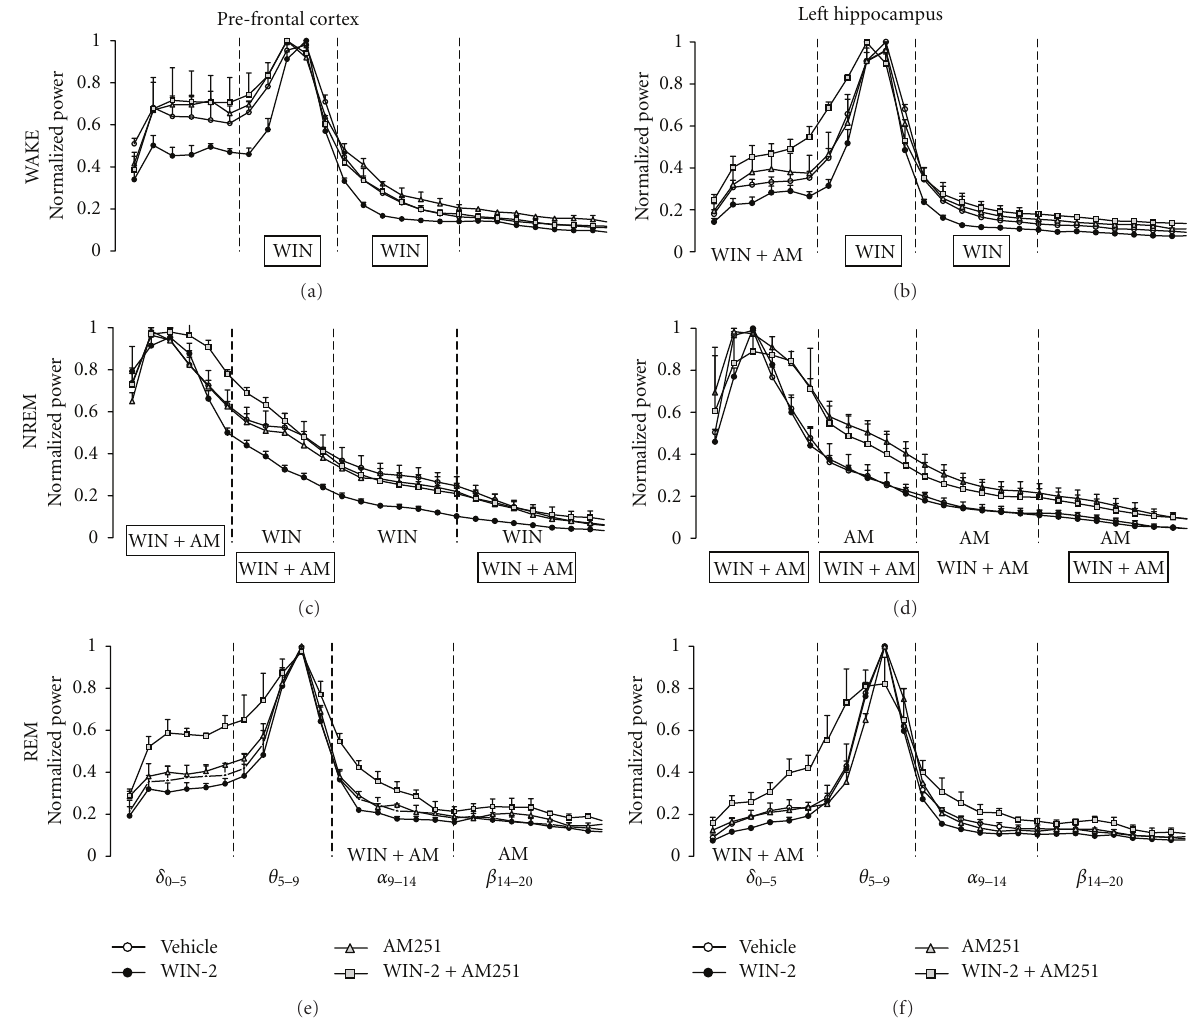
Figure 2: Normalized EEG power spectra recorded by electrodes positioned above the prefrontal cortex and parietal cortex/dorsal (left) hippocampus (frequency bands as indicated in e and f), following systemic treatment with vehicle (control), WIN-2 (1mg/kg), AM251 (2mg/kg), or WIN-2 (1mg/kg) + AM251 (2mg/kg) for vigilance stages of wakefulness (a and b), NREM (c and d) and REM (e and f) sleep, respectively. Significant e ff ects of treatment are depicted as WIN (WIN-2), AM (AM251), and WIN + AM (WIN-2 + AM251) for respective frequency bands in each subfigure (a–f). Rectangular markings indicate e ff ects common to both prefrontal and parietal recording sites. The normalized power for all data points (0.77 Hz increments from 0 to 20 Hz) is represented as mean ±